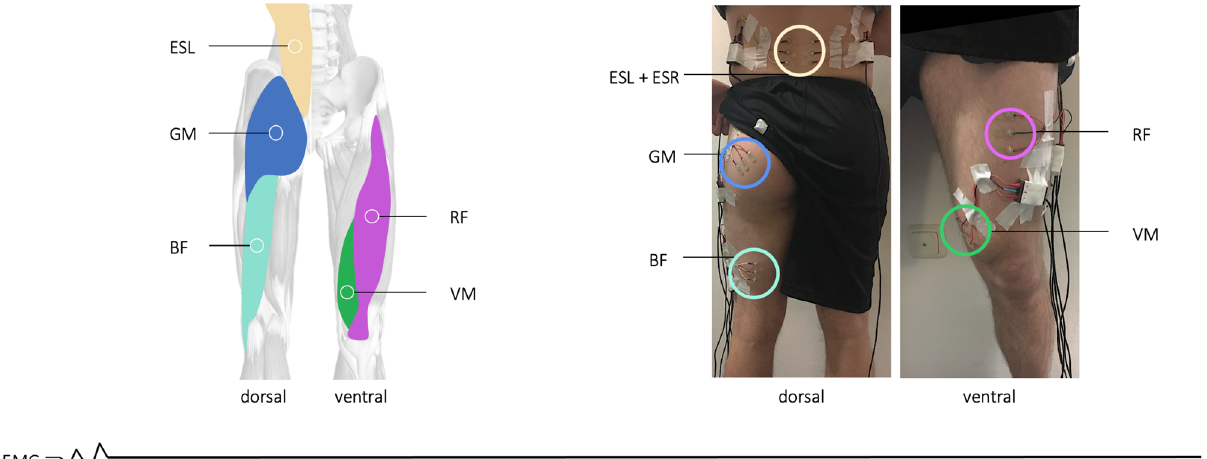
Figure 3. Schematic representation of the EMG sensors (left) attached to the participant’s dorsal and ventral lower limb and to the lumbar spine (right), including the muscle designations. Vastus medialis (VM), rectus femoris (RF), biceps femoris (BF), gluteus maximus (GM), left erector spinae (ESL), and right erector spinae